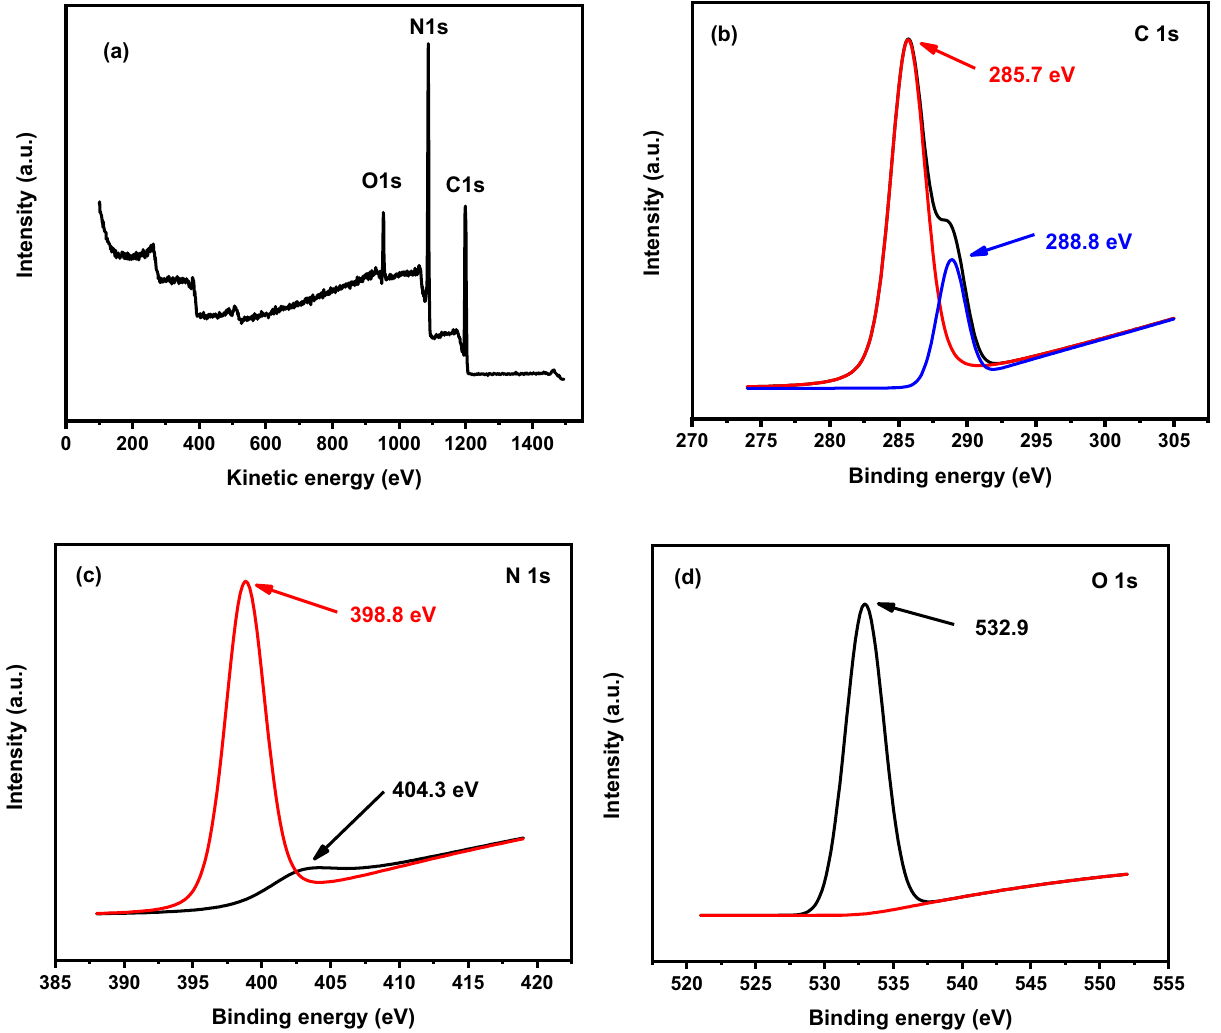
Figure 13. XPS spectrum of the GQDs\g-C3N4 sample: ( a ) Survey, ( b ) C 1 s, ( c ) N 1 s and ( d ) O 1